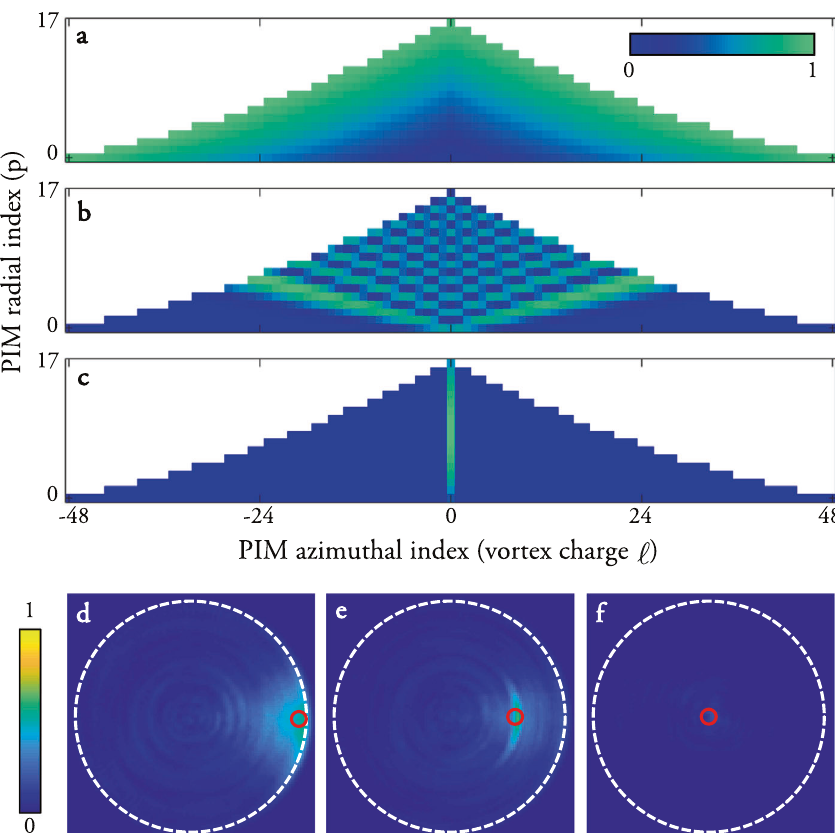
Fig. 5 Choice of guide-star location. a – c Theoretical absolute values of the level of overlap of all PIMs with three different guide-star locations. The scale- bar indicates the relative amplitude of the each PIM. Maps ( a – c ) corresponds to guide-star locations shown by red circles in ( d – f ). The colour of point ℓ , p in PIM maps represents the relative level of overlap of ψ ℓ , p with the speci fi ed guide-star location. d – f Experimentally measured power-ratio maps using ATMs reconstructed from guide-stars in the three different locations, marked with red circles. The scale-bar indicates the power-ratio across the distal facet. A guide-star positioned at the core-cladding interface gives the greatest level of overlap with all of the PIMs and therefore the largest isoplanatic patch. A guide-star positioned on the fi bre axis achieves the lowest level of overlap with the PIMs, and the isoplanatic patch shrinks to a single diffraction limited point in this